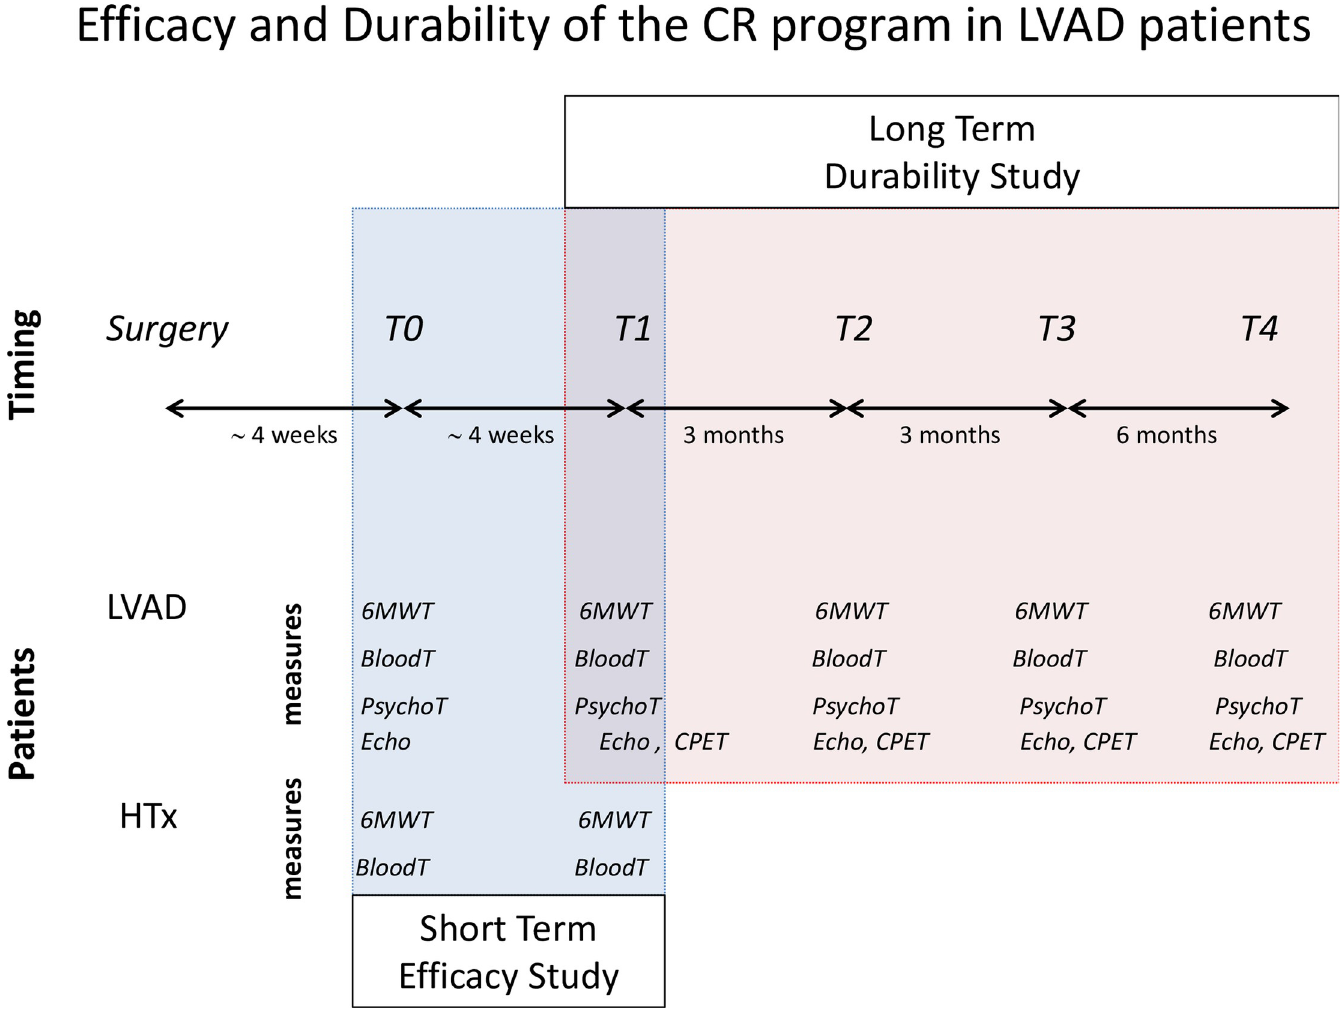
Fig 1. Timing, measures, and patients of the studies on the short-term efficacy of the cardiac rehabilitation (CR) program and long-term durability of its effects in patients implanted with a left ventricle assist device (LVAD). The efficacy study is based on the outcomes of the six-minute walk test (6MWT), blood chemistry test (BloodT), psychological tests (PsychoT), and echocardiogram (Echo) at admission (T0) and discharge (T1) of the CR program in 25 LVAD patients; reference values are derived from a matched group of 25 heart transplant patients (HTx) who underwent the same CR program, selected from the Hospital database. The durability study is based on the outcomes of 6MWT, BloodT, PsychoT, Echo, and the cardiopulmonary exercise test (CPET) in the LVAD patients at T1 and follow-up visits three months (T2), six months (T3), and one year (T4) after